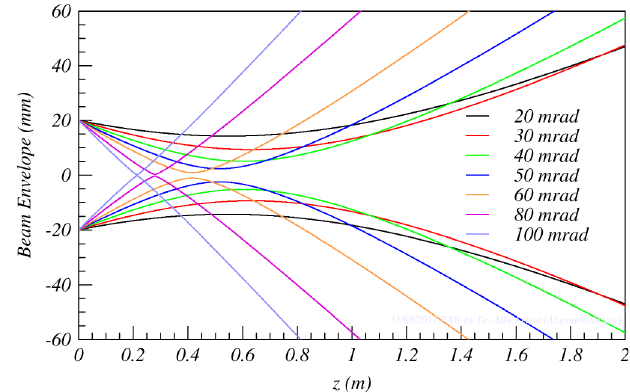
FIG. 4. 4 He þ 50 keV, 50 mA initially uniform (initial emit- tance (cid:3) 4 rms ¼ 4 (cid:2) mm mrad ), 2 cm radius, free drifting beams (neutralization 90%) for several initial converging angles. The longest drifting distance for the beam to reach the same initial radius is 1.3 m for the 30 mrad convergent beam.